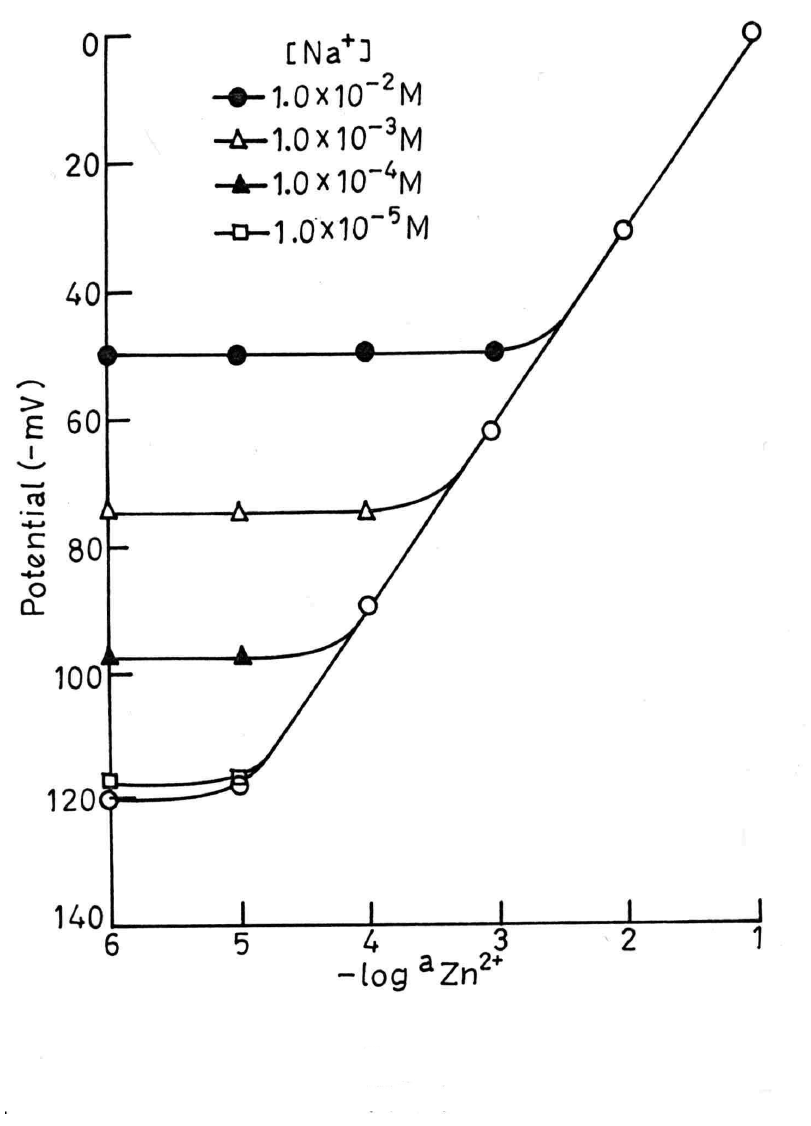
Fig.4 : Variation of potential with Zn 2+ concentration in presence of different concentration of Na +